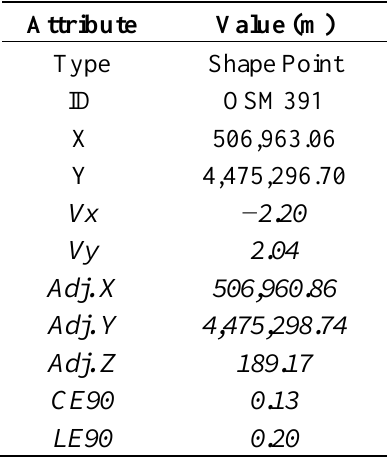
Table 5. Shape point